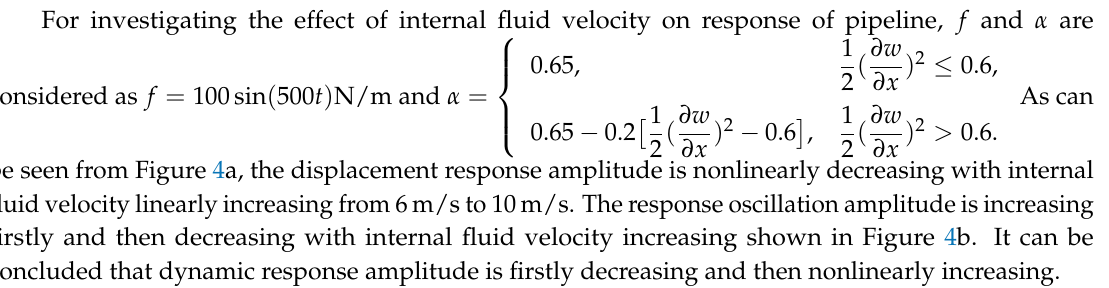
Figure 3. Dynamic response on the viscoelastic pipeline conveying fluid when n values 4 within 50 s for ( a ) three-dimensional displacement map and ( b ) contour displacement